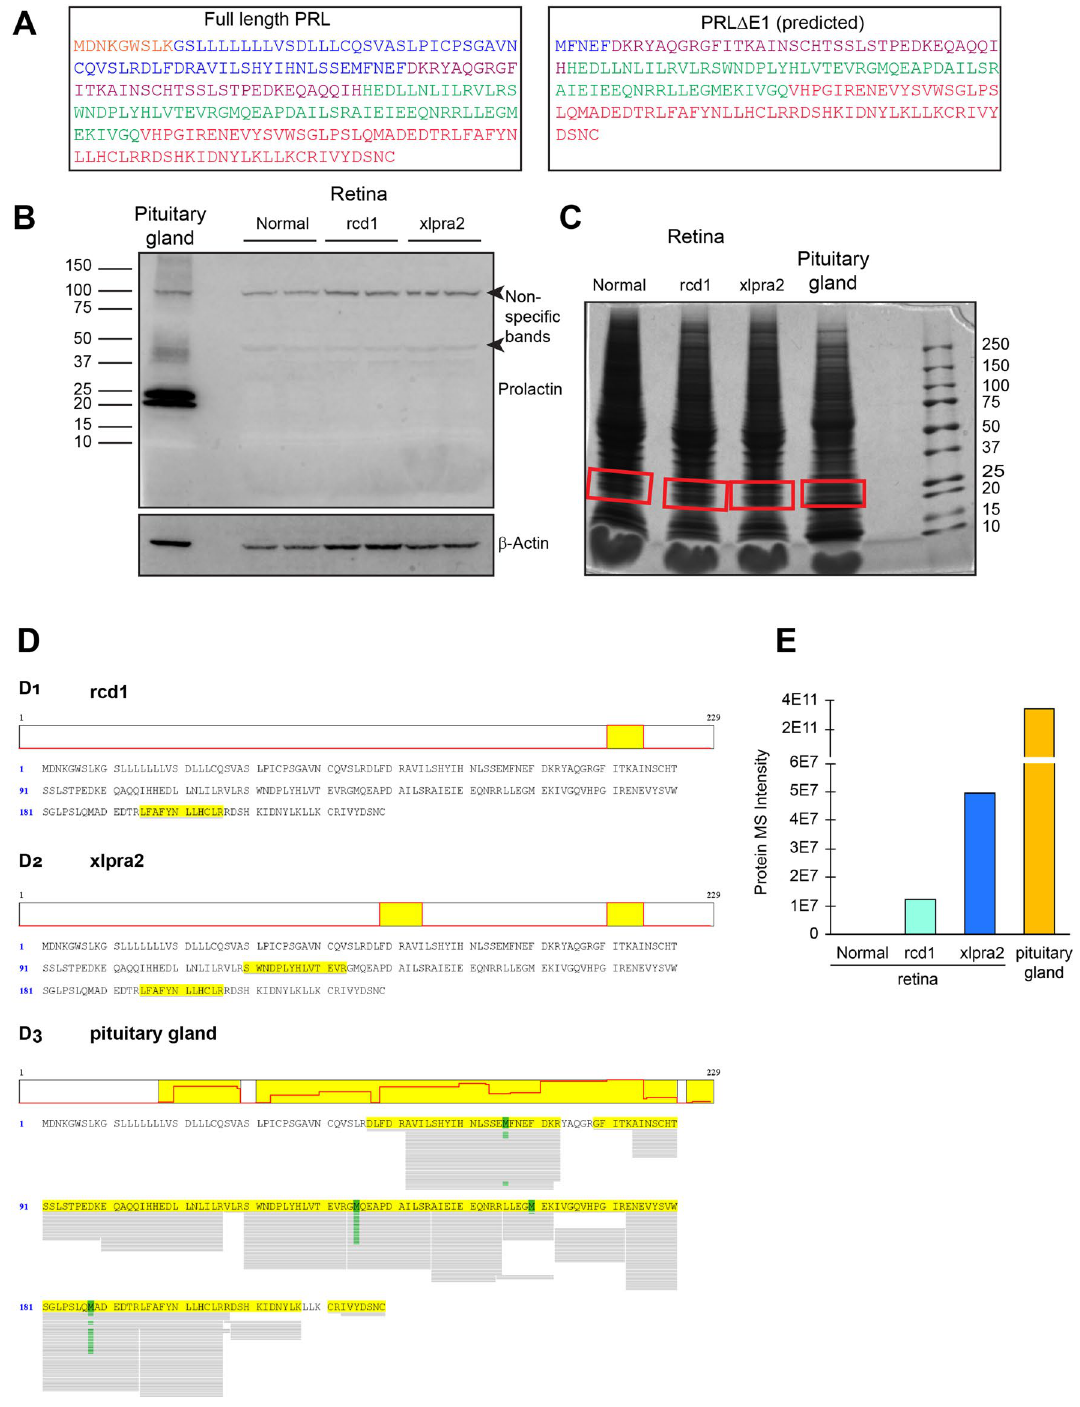
Figure 5. Prolactin protein expression in dog retinas. (A) Protein sequence for PRL from dog pituitary gland and predicted protein sequence for PRLΔE1 with the amino acids corresponding to each exon shown with different colors. ( B) Immunoblot for PRL from dog pituitary gland (n = 1) and normal and mutant retinal extracts (n = 2 for each). ( C) CBB-stained SDS-PAGE gel for MS/MS analysis with the bands used for analysis highlighted in red. ( D) Mass spectrometry results showing PRL-specific peptides identified from each sample (highlighted in yellow) (D1) rcd1 retina (age: 22 weeks, n = 1), (D2) xlpra2 retina (age: 41 weeks, n = 1), and (D3) normal canine pituitary gland. ( E) Protein MS intensity for PRL peptides identified from retinal and pituitary gland